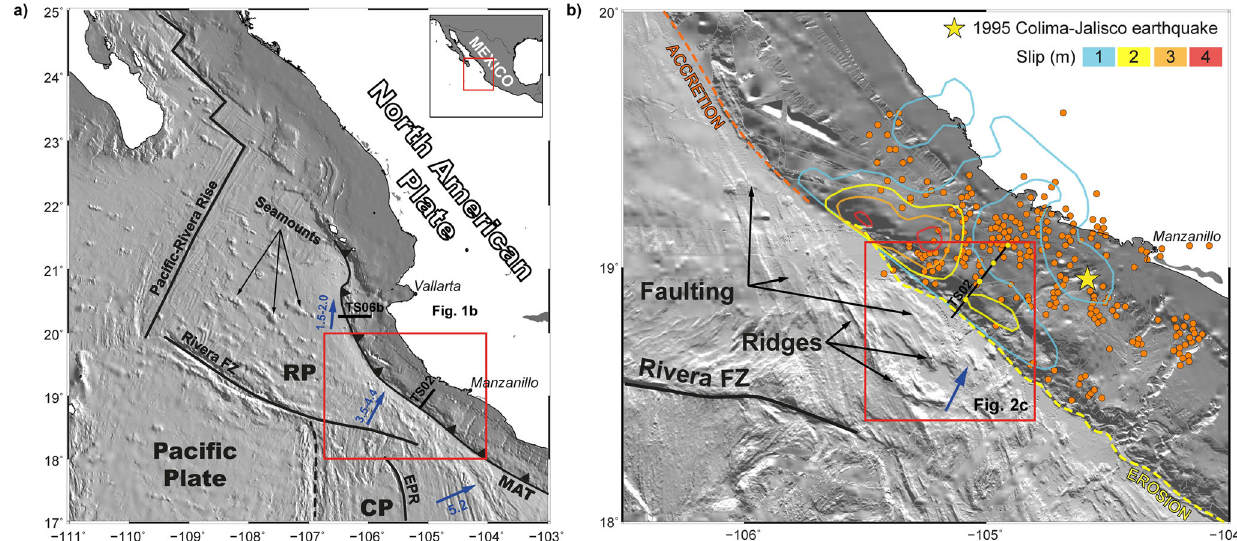
Fig. 1 Oceanic fabric, margin architecture and seismicity associated with the 1995 megathrust earthquake. a Regional map of the Rivera subduction zone depicting the study area (red box), and the location of the seismic line TS02 (this study) and TS06b 10 . Blue arrows are convergence vectors in cm yr − 1 from ref. 8 . NW-SE seamounts chains are marked in the fi gure with black arrows. The Rivera Fracture Zone (FZ) sets the boundary between the Rivera plate, and the Paci fi c and Cocos oceanic plates. MAT Middle America Trench. b Close-up of the study area showing the presence of bending-related faulting and trench-parallel oceanic ridges in the outer rise. The epicentre and distribution of the 1995 Colima-Jalisco earthquake are shown in the fi gure 18 , together with the associated aftershock distribution 19 . Yellow dots along seismic line TS02 are ocean-bottom